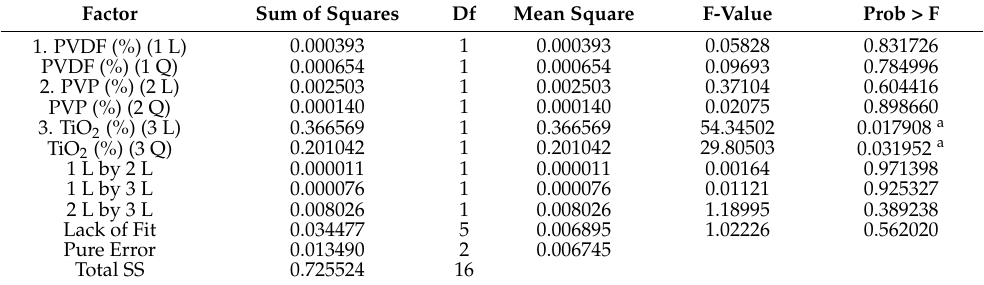
Table 10. Analysis of variance of initial reaction rates (r) determined under acidic conditions (pH = 3) in methyl orange solution. R 2 = 0.93389; Pure error = 0.0067452. (L) is the linear relation, (Q) is the quadratic relation of the factors, and Df is the degrees of freedom of the analysis.